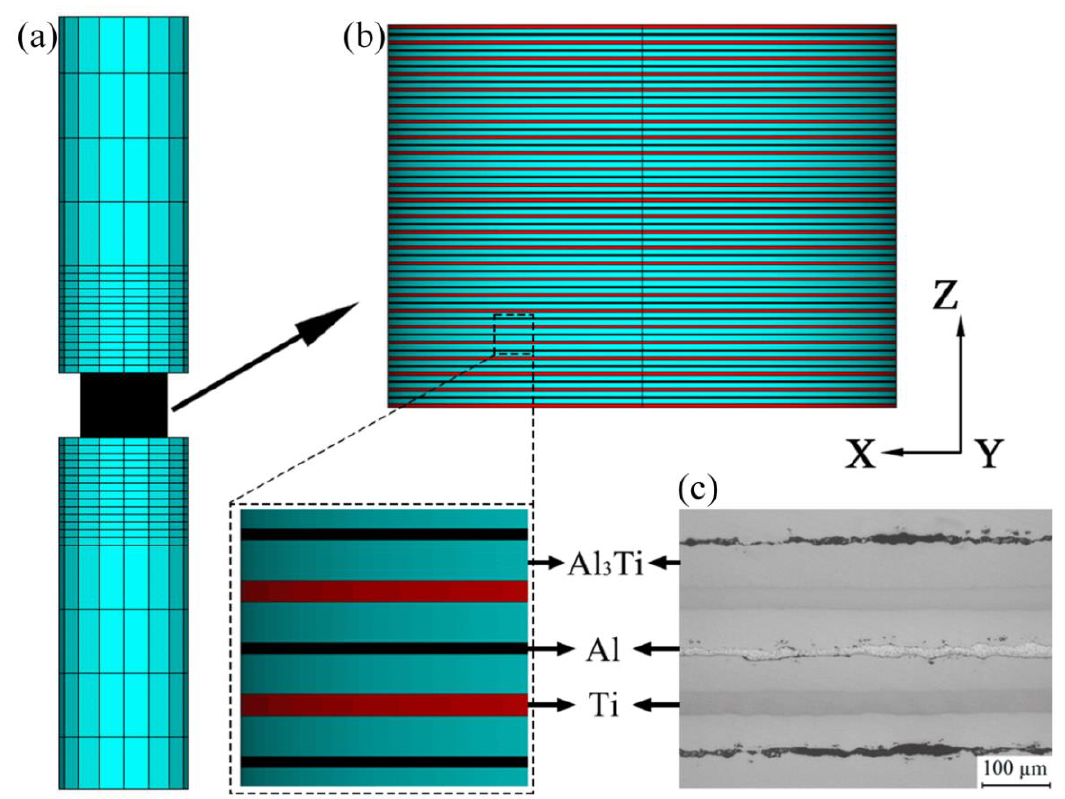
Figure 2. ( a ) The finite element mesh SHPB experiment system (local), ( b ) Finite element model of Ti–Al3Ti–Al specimen, ( c ) Metallographic diagram of Ti–Al3Ti–Al specimen. Table 2. Size parameters of the target model containing different percentages of Al.